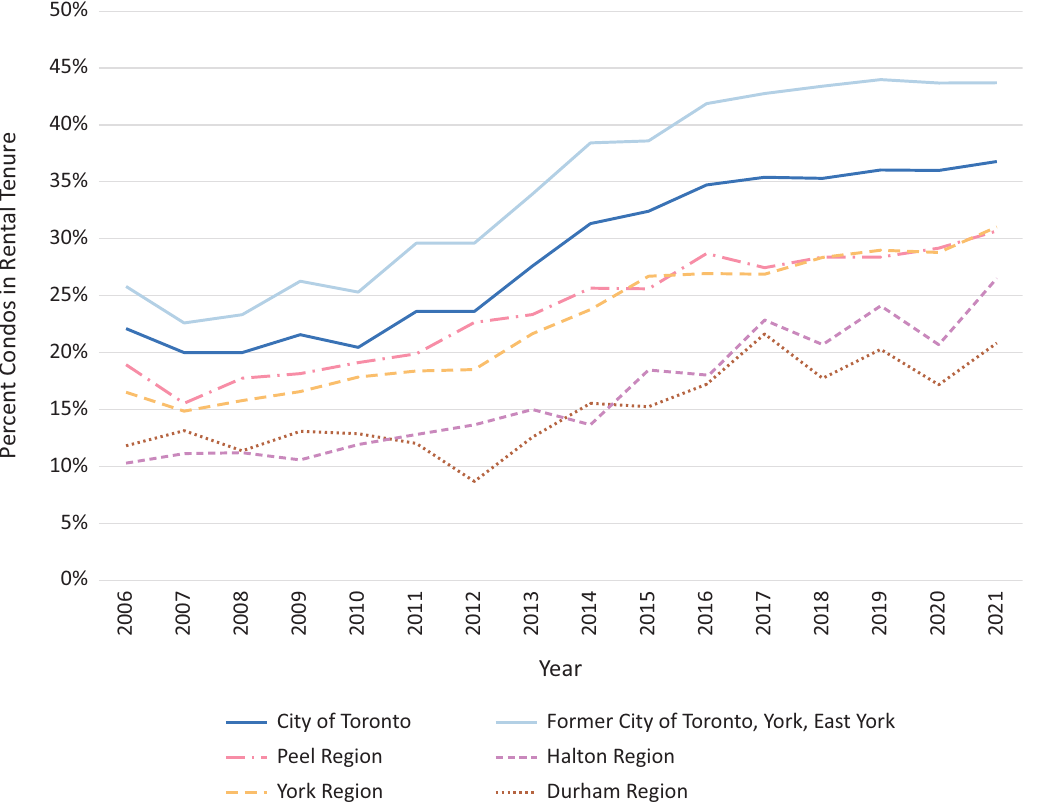
Figure 6. Percentage of condos in rental tenure by region in the Toronto CMA between 2006 and 2021. Source: Calculated by the authors using data from CMHC